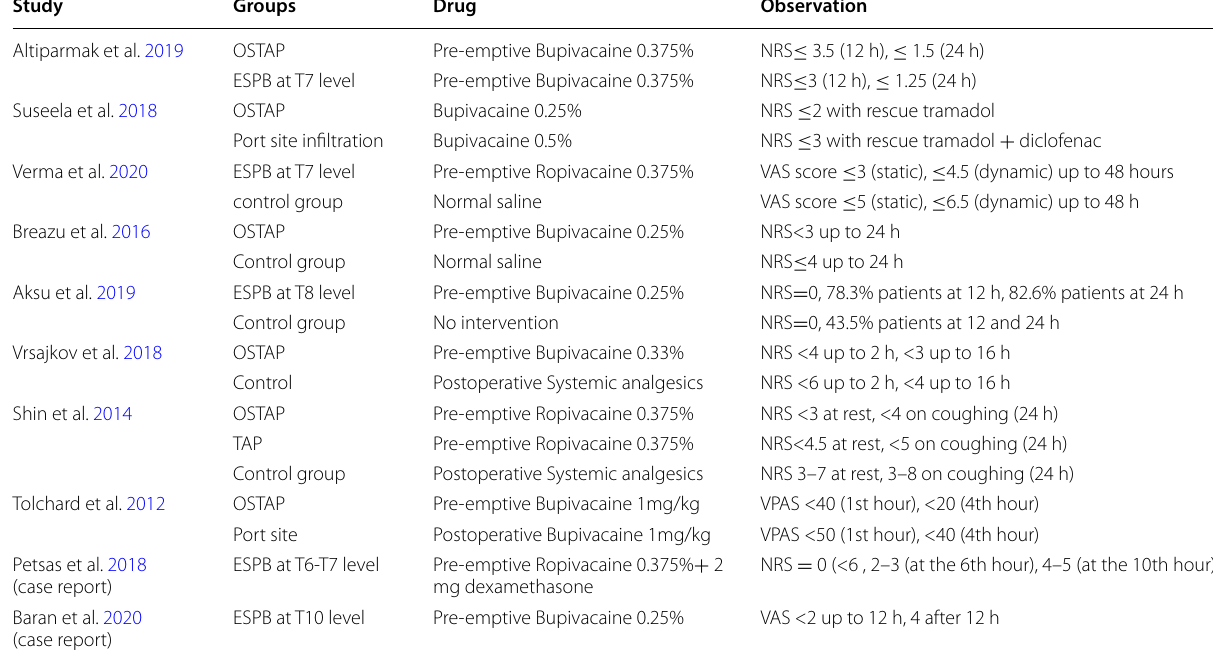
Table 4 Methods and observations of prior studies